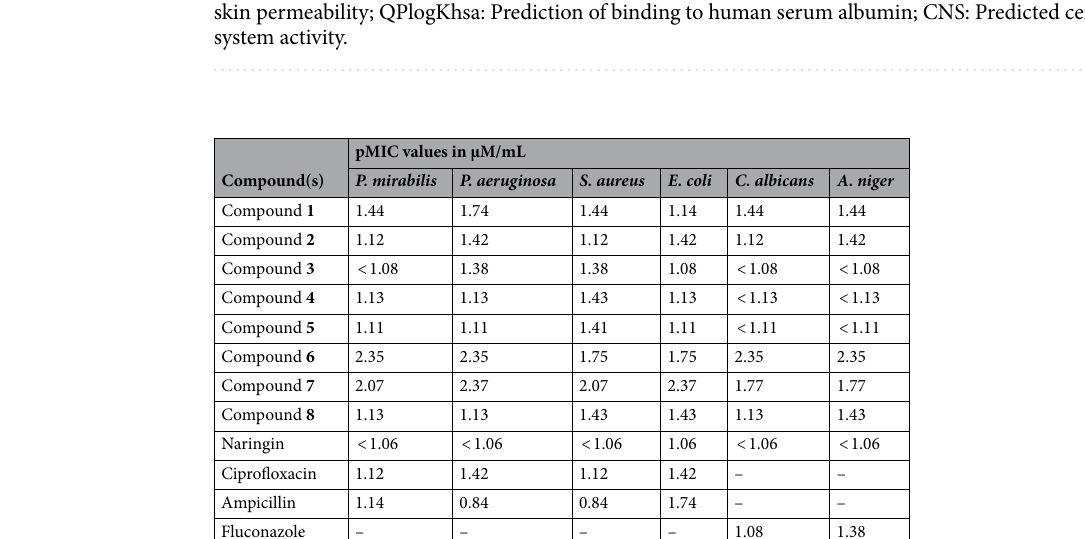
Table 2. Results of molecular docking and ADMET parameters for proposed naringin derivatives. QPPCaco: Caco-2 cell is a model for the gut-blood barrier; QPlogBB: Predicted brain/blood partition coefficient;